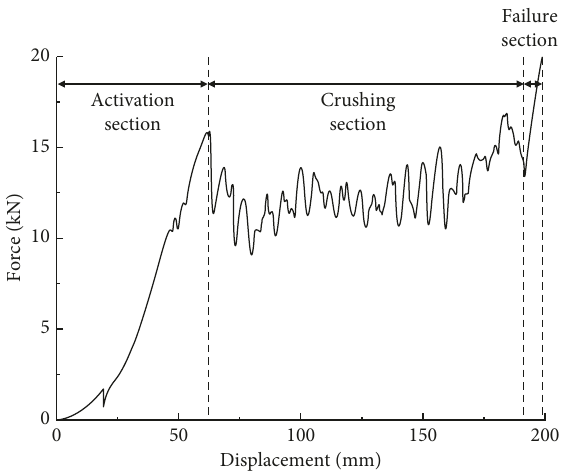
Figure 12: Typical load-displacement curve of the tube-crushing dissipator and the symmetric tube-crushing dissipator in the quasistatic Table 5, the active force thresholds of the tube-crushing